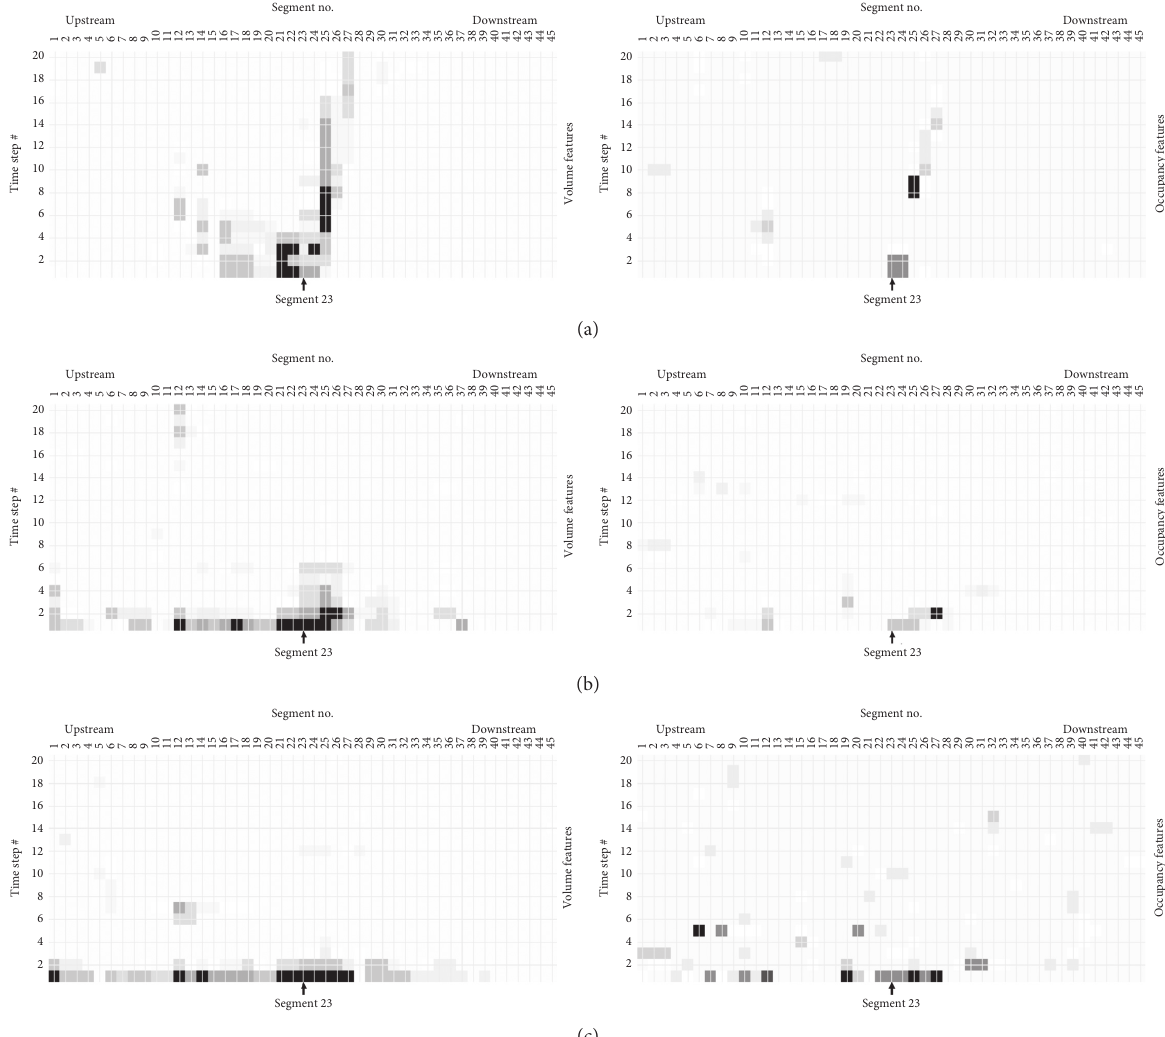
Figure 9: Ranking of attributes in terms of their relative importance to the performance of SVR models, for three different input data aggregation levels (segment 23). The plots for the volume features are on the left and those for the occupancy features are on the right. (a) 30sec aggregation level. (b) 5min aggregation level. (c) 15 min aggregation